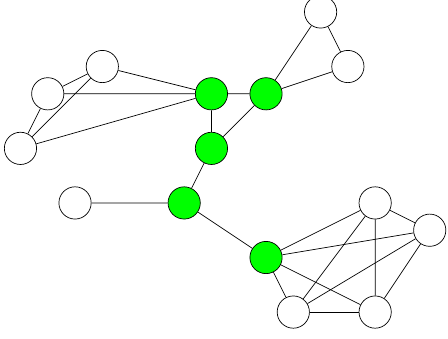
Figure 5. Connected dominating set. The dominators are colored in